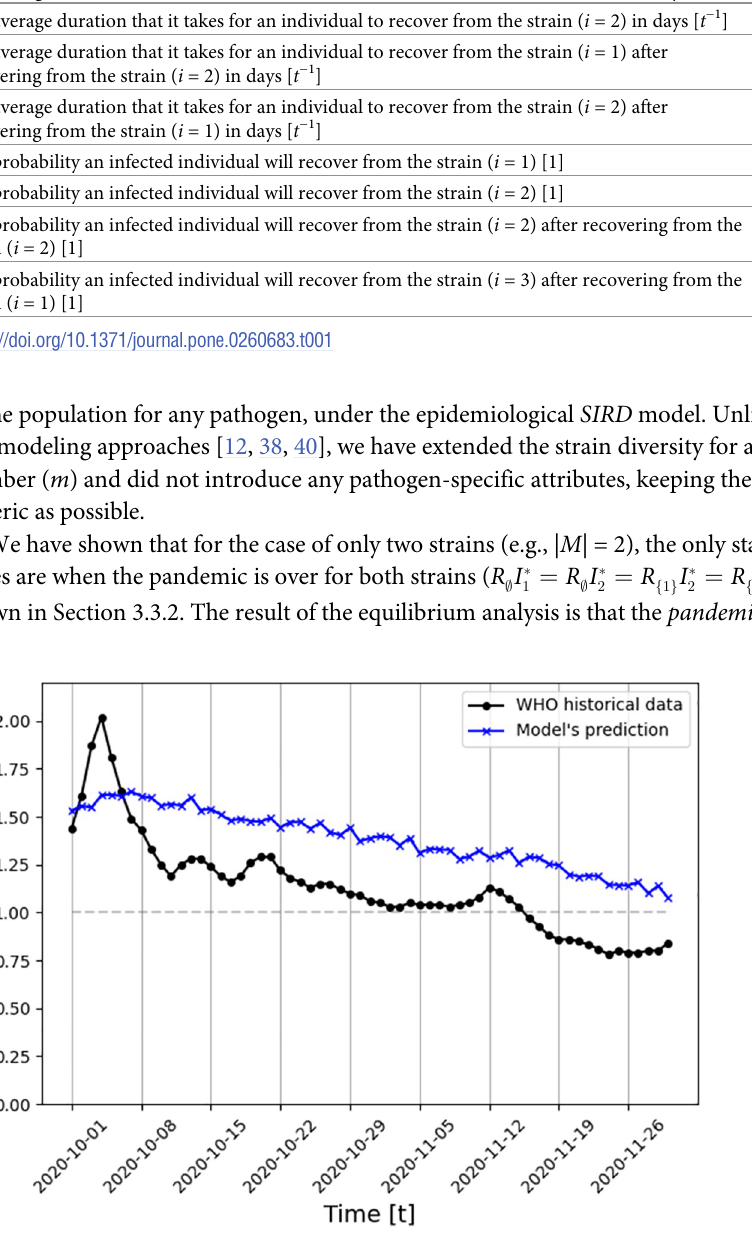
Fig 7. Daily R 0 in UK between September 1 and December 1 (2020) comparison between the historical data (specifically, the daily number of infected, recovered, and dead individuals) and the proposed model predictions (for | M | = 2). The gray horizontal line indicates R 0 = 1. The model’s parameter values are shown in Table 1.